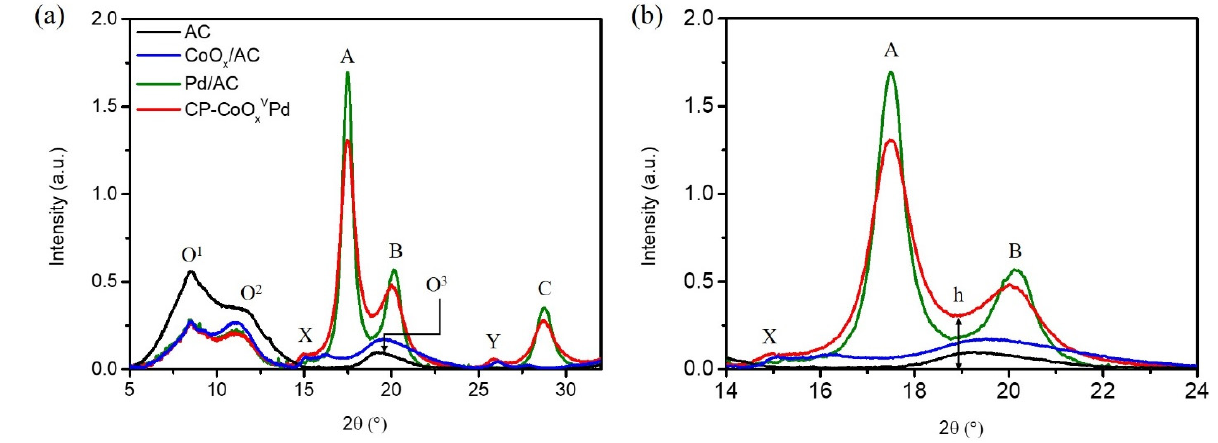
Figure 2. ( a ) The comparative XRD patterns of CP-CoO xV Pd NC and reference samples (AC, CoO x /AC, and Pd/AC). The enlarged XRD pattern at the 2 θ range between 14° and 24° is shown in ( b ). The wavelength of incident X-ray for XRD measurement is 0.6888 Å (18.0 KeV).